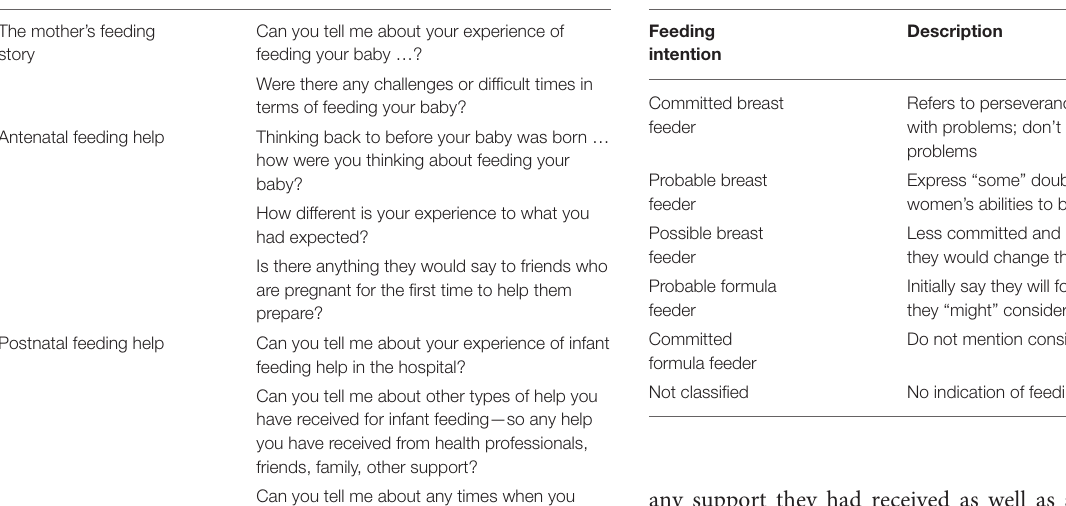
TABLE 2 | Classification of breastfeeding intentions (Hoddinott and Pill,